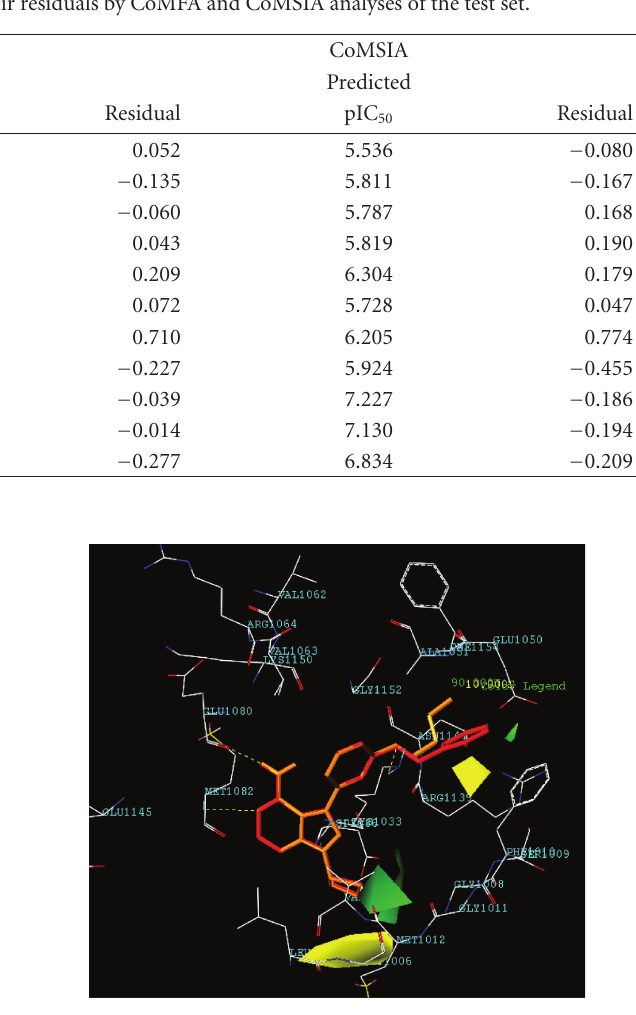
red- and blue-colored contours while steric interactions are represented by green and yellow colored contours. In electro- static field, blue color contour represents region where